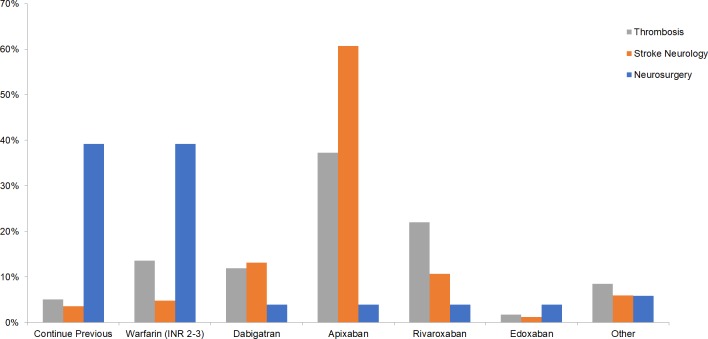
Overall response from survey participants on timing of OAC re-initiation across 11 clinical scenarios.ICH, intracerebral haemorrhage; DOAC, direct oral anticoagulants; IPH, intraparenchymal haemorrhage; HTN, hypertension; CHADS2, Congestive heart failure, hypertension, age (≥75), diabetes, stroke/TIA score.